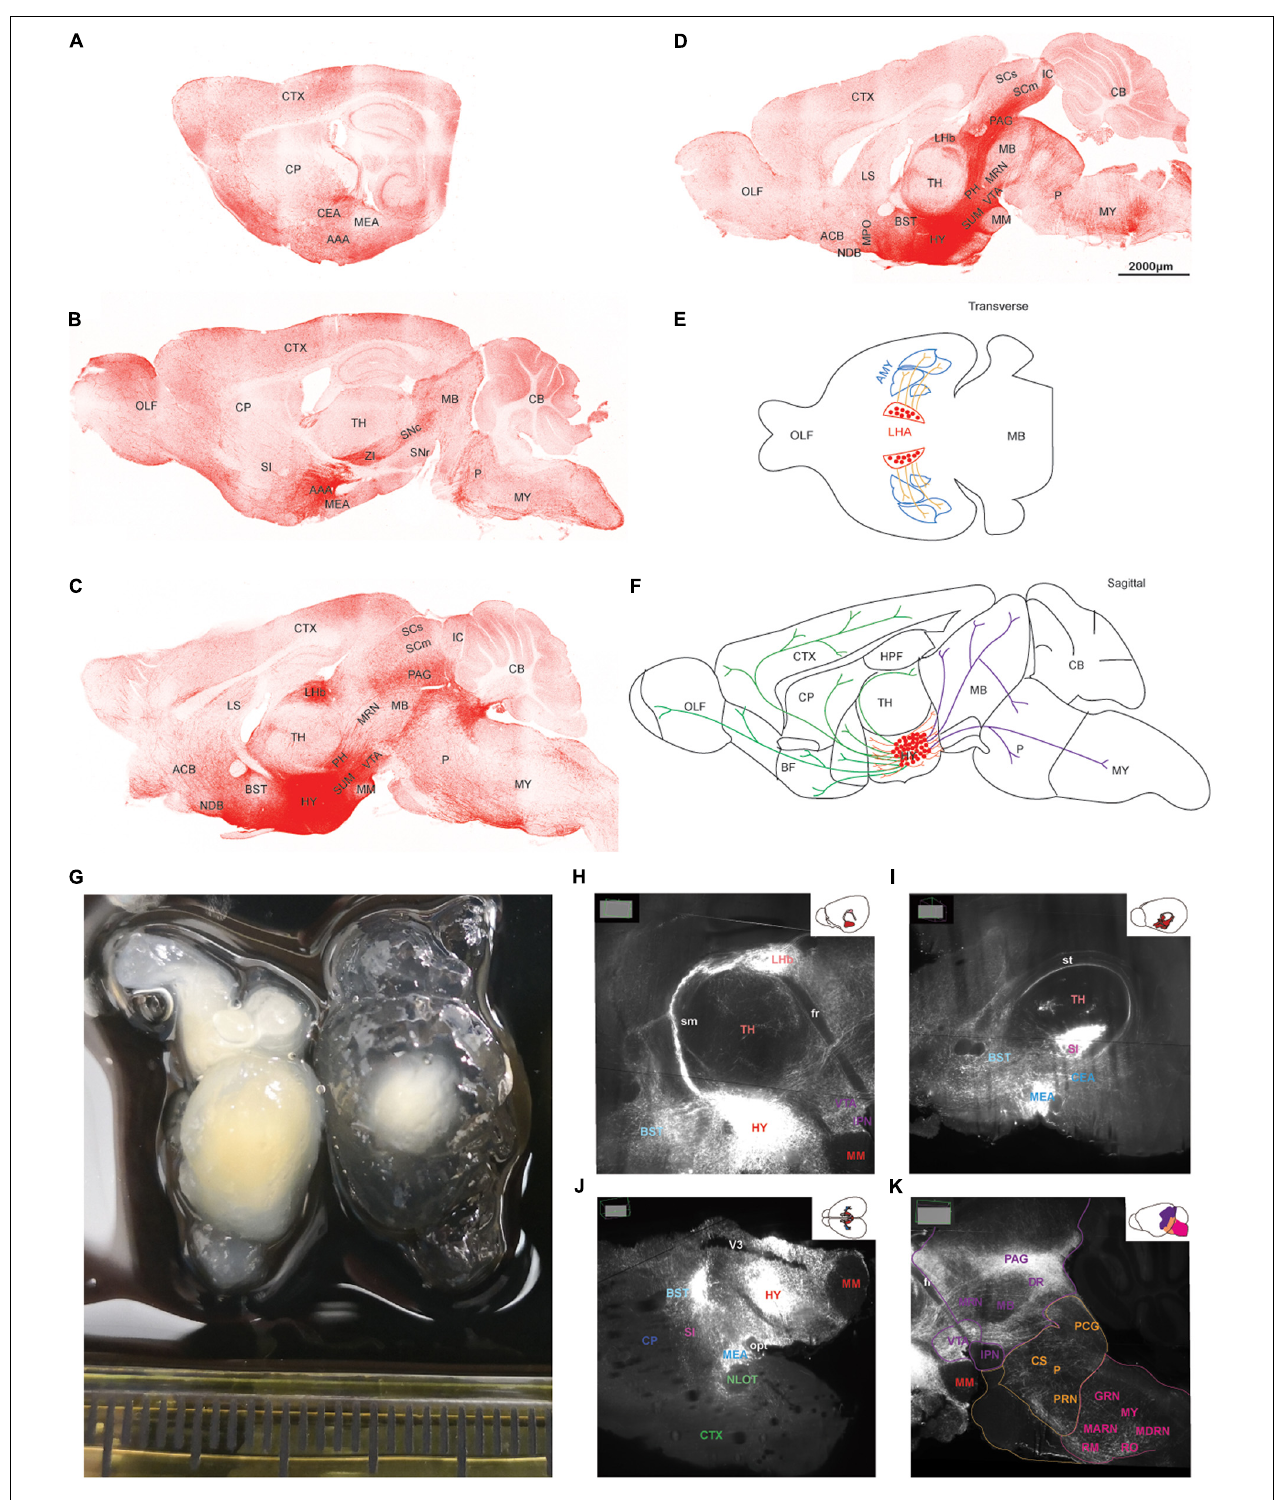
FIGURE 2 | The topography of orexin projections. Orexin-Cre mice were injected with AAV5-DIO-ChrimsonR-tdT into LHA. (A–D) Representative confocal images from lateral to medial showing the orexin projections in sagittal planes. (E,F) Schematic drawings of lateral (E) , hypothalamic, rostral, and caudal (F) projections of orexin neurons. (G) Two hemispheres of mouse brain underwent tissue clearing for 1 week (left) and 3 weeks (right). (H–K) Orexin projections revealed by the lightsheet microscope. The images were chosen at particular angles to show certain interesting projection features. AAA, anterior amygdalar area; ACB,